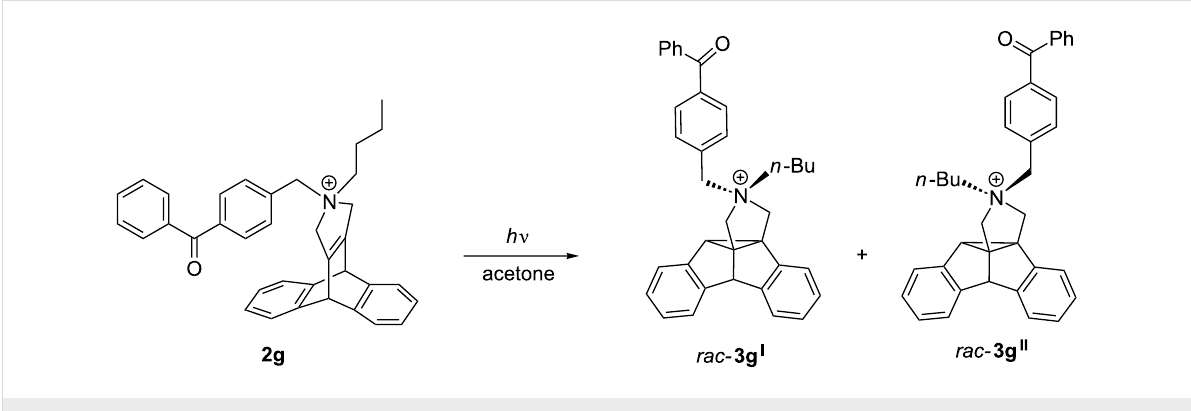
Scheme 4: Di- π -methane rearrangement of dibenzobarrelene derivative 2g